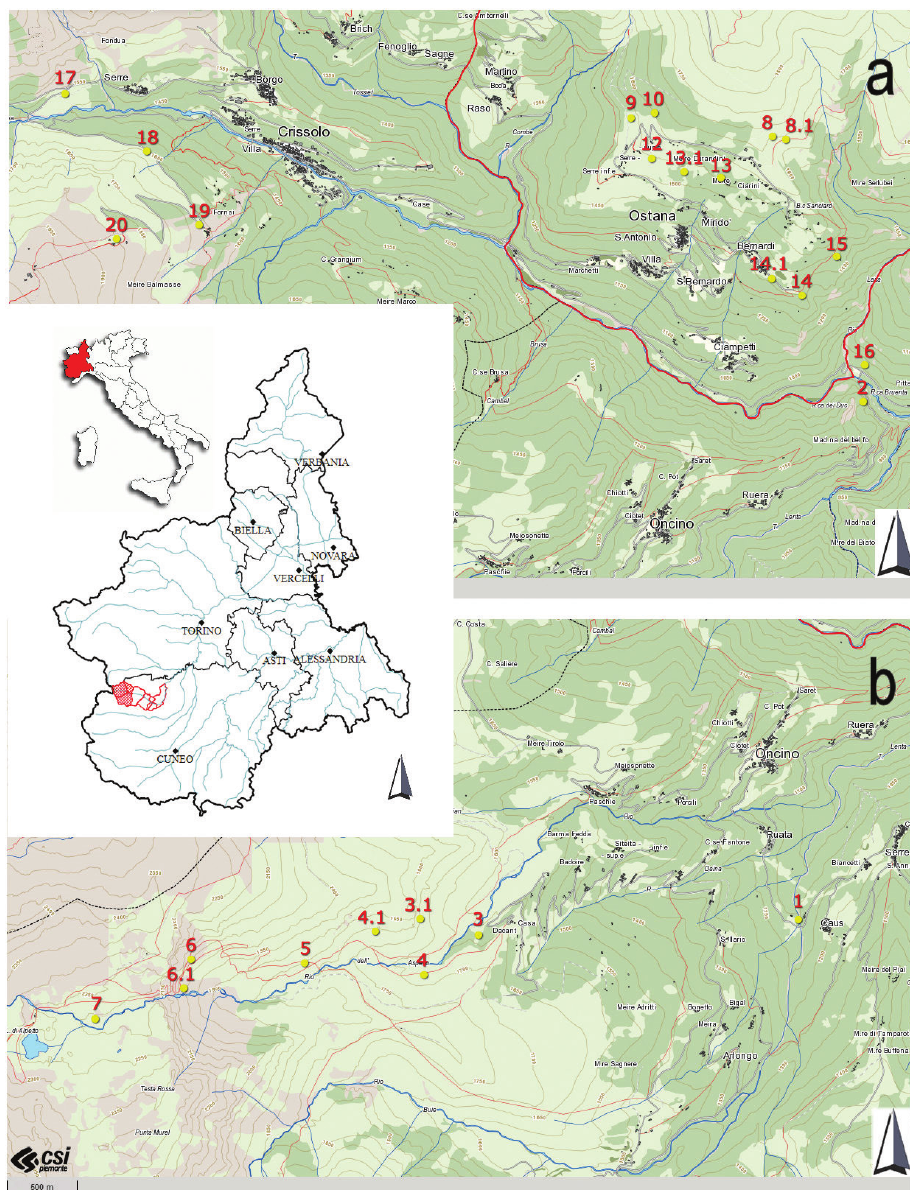
Figure 1. Area where the annual field trip of the working group for Floristics, Systematics and Evolution of the Italian Botanical Society took place and topographic maps (scale 1:20,000) with collecting sites (number and yellow dots). For detailed data of each site, see Suppl. material 1: 5. a July, 9 (site n. 2), July, 11 (from site n. 8 to n. 16), July, 12 (from site n. 17 to n. 20) b July, 9 (site n. 1) and July, 10 (from site n. 3 to n. 7). From: GeoPortale Piemonte (Regione Piemonte –